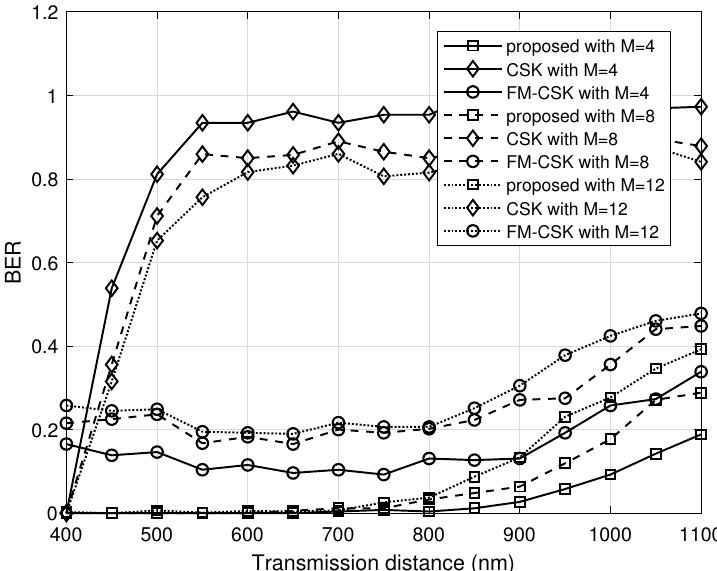
Figure 3. Comparison of the different approaches of BER performance by varying the transmission distance and M .